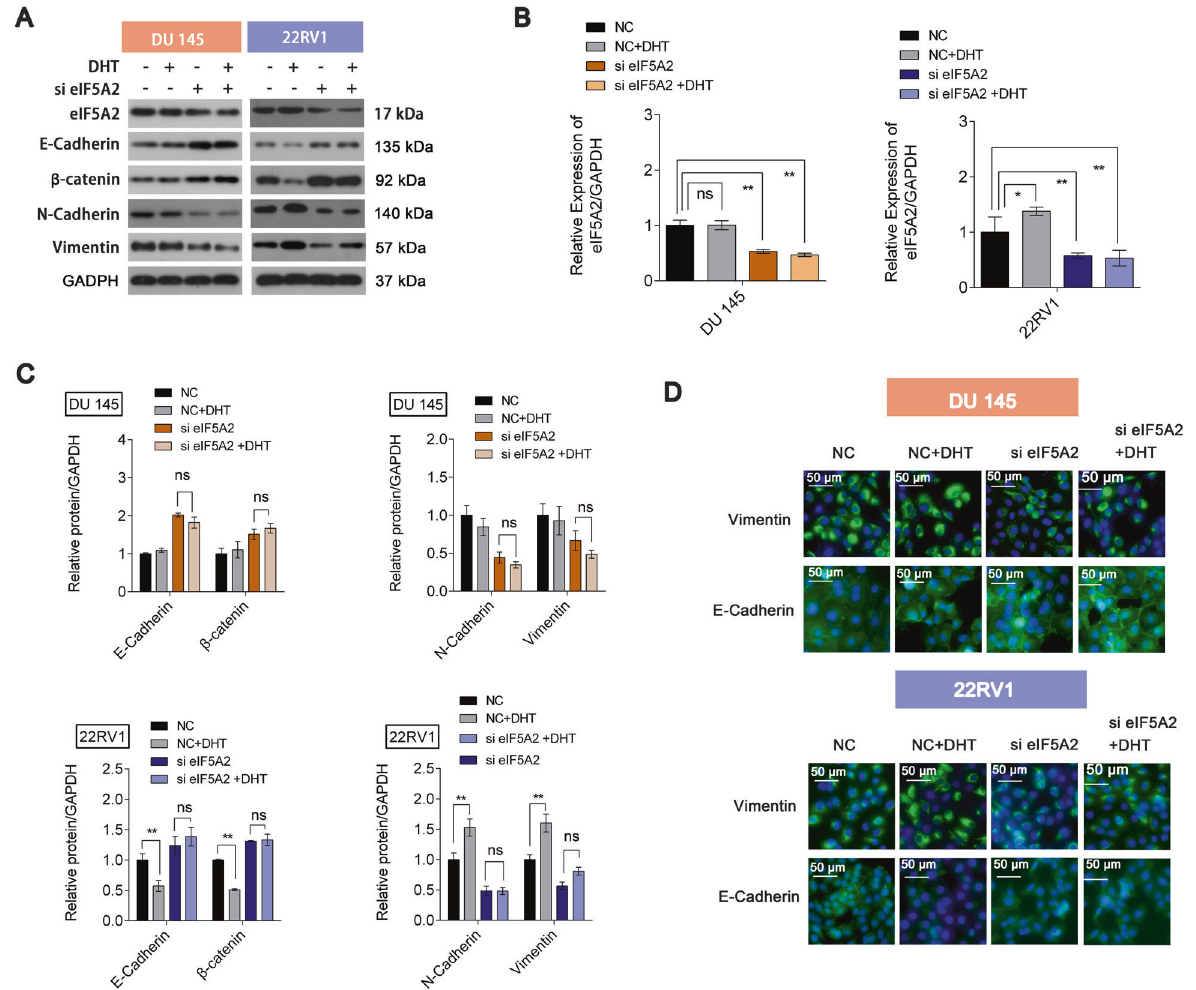
Fig. 5 Effect of eIF5A2 on EMT in the presence of DHT. A , B Expression of EMT-related proteins in DU145 and 22RV1 cells transfected with eIF5A2 siRNA or negative siRNA in the presence or absence of DHT. C mRNA expression of eIF5A2 in DU145 and 22RV1 cells transfected with eIF5A2 siRNA or negative siRNA in the presence or absence of DHT. D Immuno fl uorescence staining of E-cadherin and Vimentin in DU145 and 22RV1 cells transfected with eIF5A2 siRNA or negative siRNA in the presence or absence of